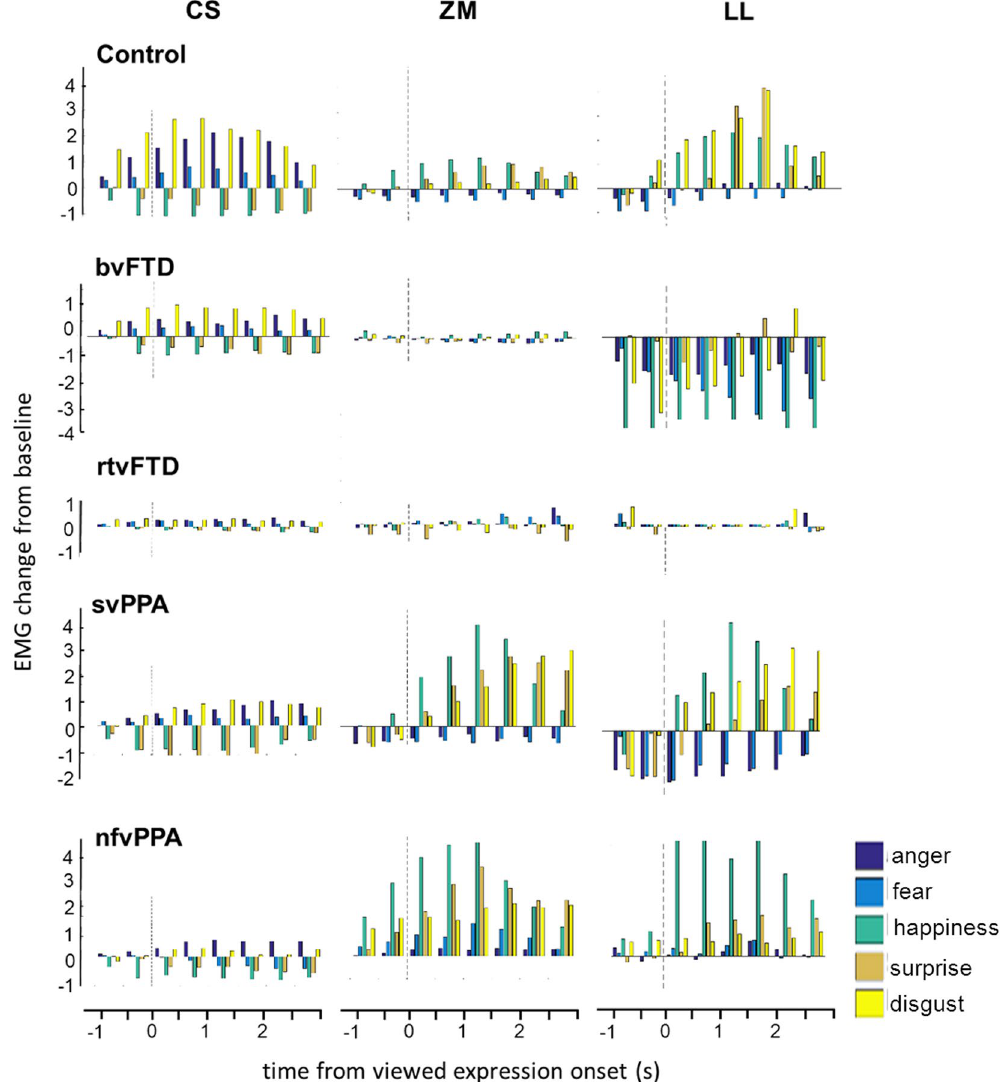
Figure 1. Patterns of EMG reactivity for each muscle in each participant group. For each participant group, the plots show the time course of average EMG reactivity (in microvolts) for key facial muscles while participants watched videos of emotional facial expressions. EMG reactivity, here indexed in arbitrary units as mean EMG change from baseline, is shown on the y-axis (after rectifying, high-pass filtering and removing artefacts as described in Methods). Onset of the viewed facial expression (as determined in a prior independent analysis of the video stimuli) is at time 0 (dotted line) in each panel. In healthy controls, corrugator supercilii (CS) was activated during viewing of anger, fear and disgust, but inhibited during viewing of happiness and surprise; zygomaticus major (ZM) was activated during viewing of happiness and surprise, but inhibited during viewing of anger and fear; and levator labii (LL) was inhibited during viewing of anger and fear, and maximally activated during viewing of disgust. Note that in healthy controls muscle responses consistently preceded the unambiguous onset of viewed emotional expressions. bvFTD, patient group with behavioural variant frontotemporal dementia (excluding right temporal cases); Control, healthy control group; nfvPPA, patient group with nonfluent variant primary progressive aphasia; rtvFTD, patient subgroup with right temporal variant frontotemporal dementia; svPPA, patient group with semantic variant primary progressive